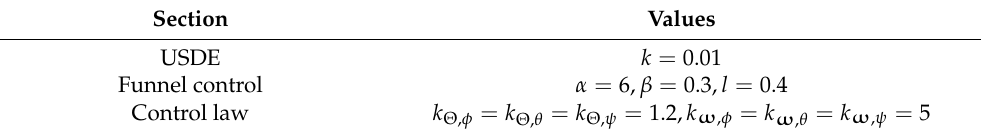
Table 2. Parameters of the controllers.